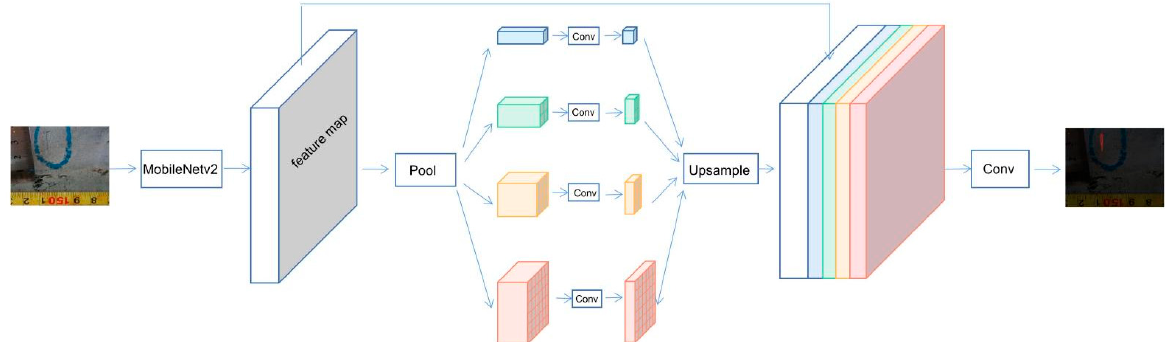
Figure 6. PSPNet structure diagram with Mobile as the backbone.